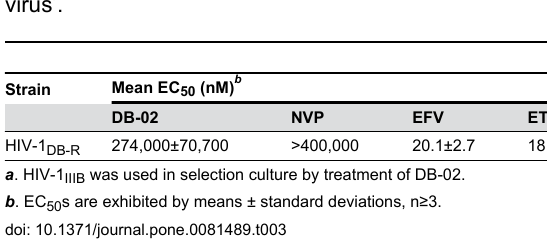
Table 5. Antiviral activity for DB-02 in combination with four FDA-approved antiviral compounds against HIV-1